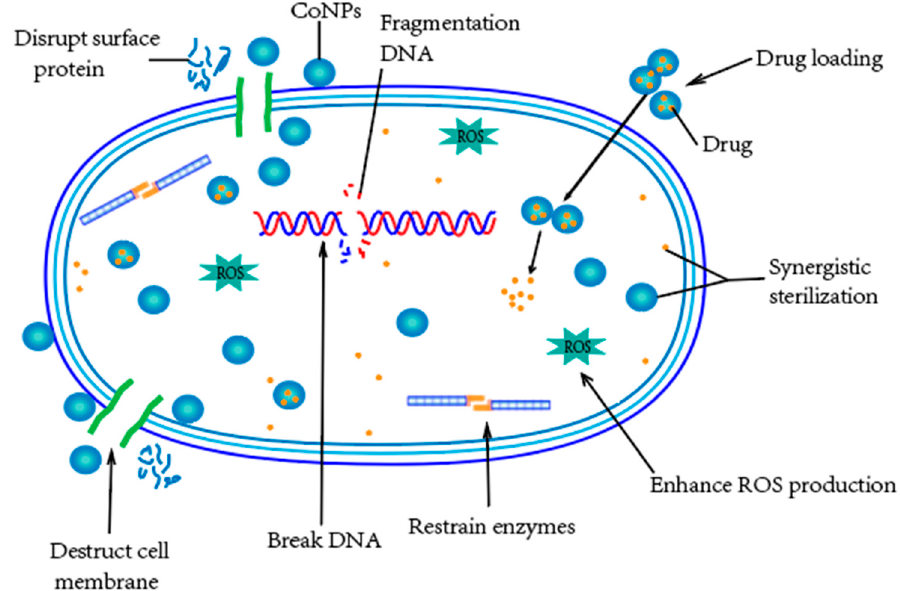
Figure 3. The distinct mechanisms against bacterial infections of cobalt nanomaterials: the surface protein and cell membrane disruption, production of ROS, destruction of DNA, inhibition of enzyme synthesis, delivery of therapeutic agents, and synergistic sterilization.